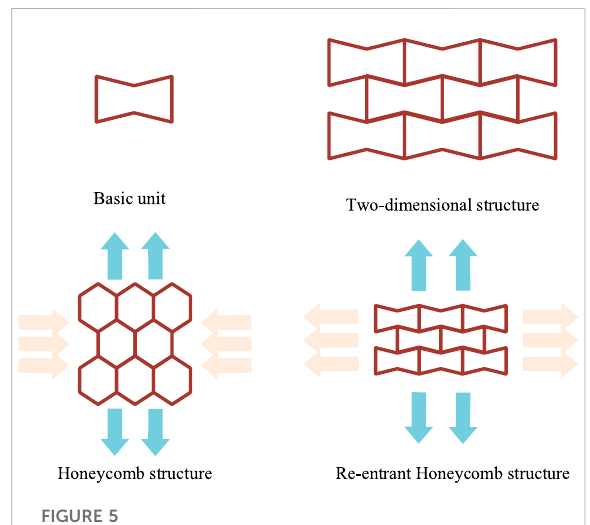
Schematic diagram of negative Poisson ’ s ratio